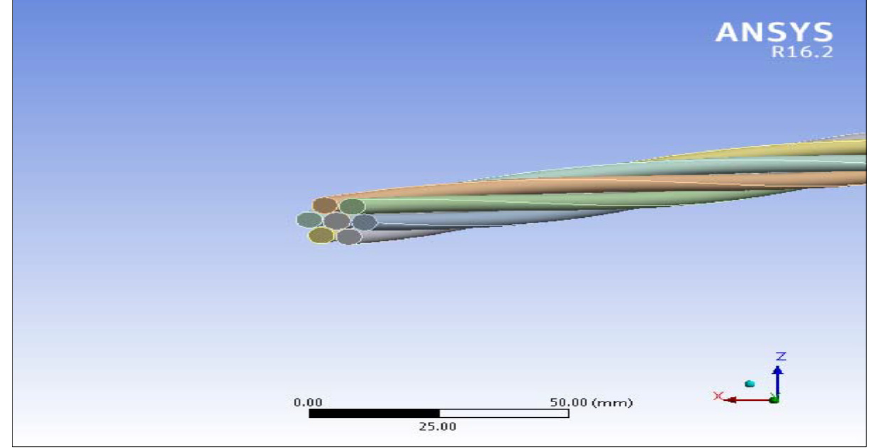
Figure 12. Simulation view of the steel wire rope.